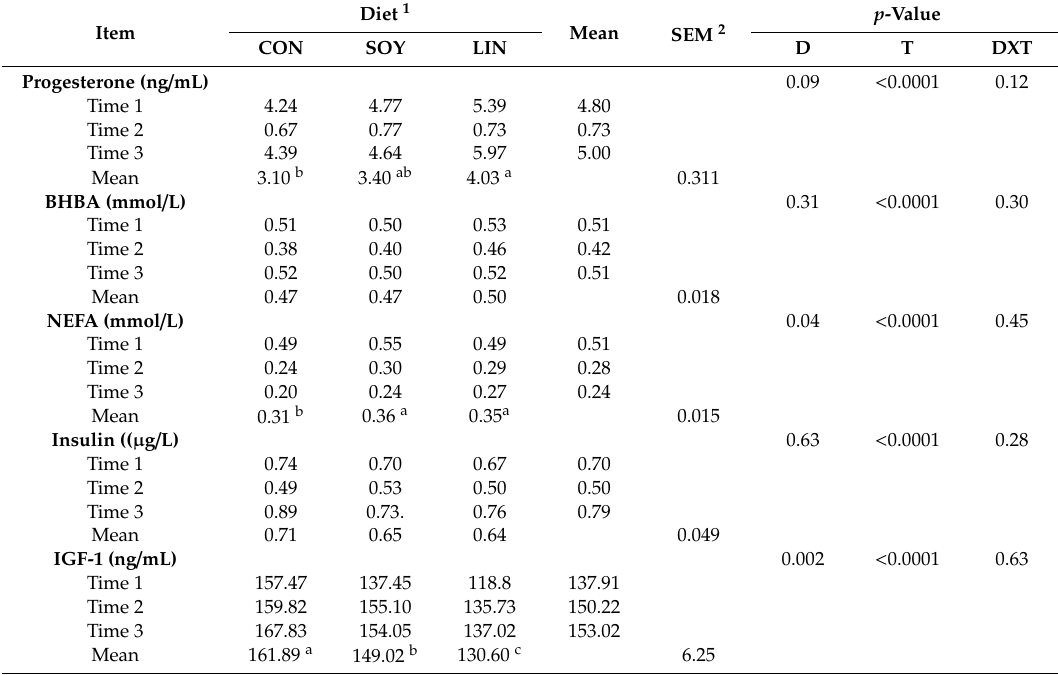
Table 6. Progesterone and metabolites concentration in